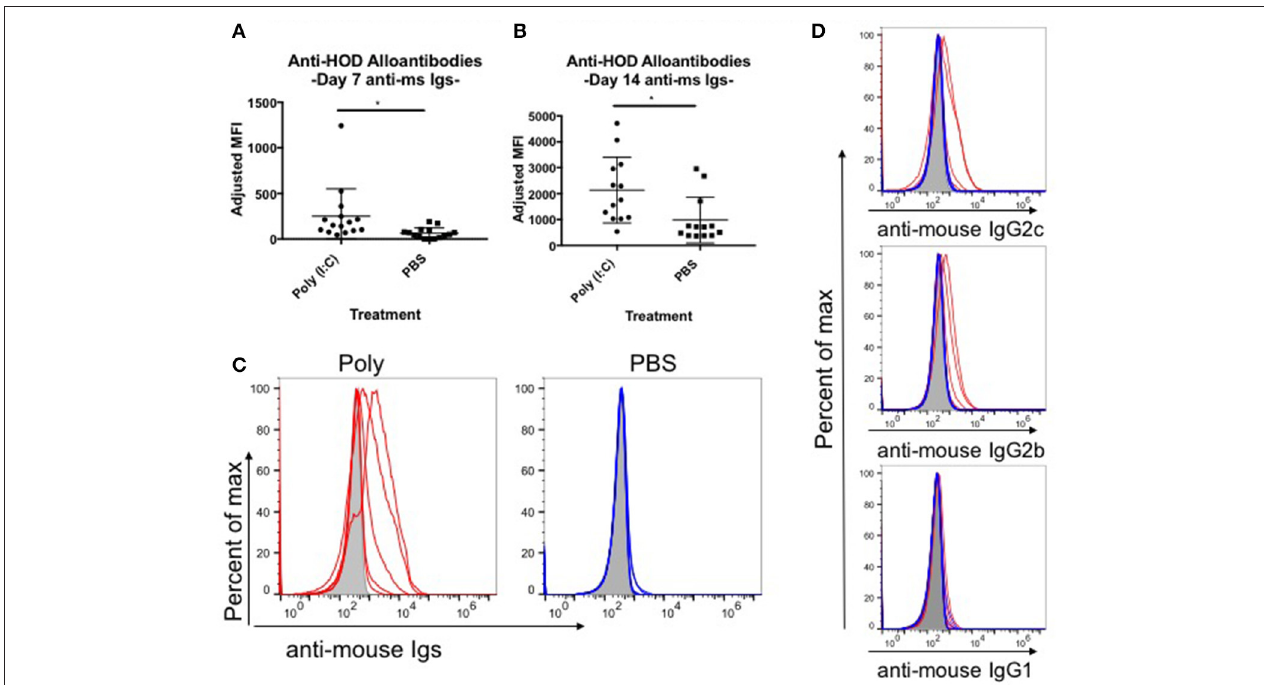
FIGURE 1 | Poly (I:C)-elicited inflammation enhances the magnitude and rate of alloimmunization to HOD RBCs. Recipient B6 mice were treated i.p. with 200 ug of poly (I:C) or PBS control 2–4h prior to a transfusion of 100 uL packed leukoreduced HOD RBCs. Sera was collected and assessed for anti-HOD alloantibodies by flow crossmatch against HOD RBC targets. The adjusted mean fluorescence intensity (MFI) of anti-mouse Igs APC secondary staining reagent was determined for days (A) 7 and (B) 14 post RBC transfusion. (C) Reactivity of day 14 serum to HOD RBC targets from individual mice in each group is shown by flow crossmatch against HOD RBC targets with total anti-mouse Igs and (D) subtype specific IgG secondary reagents. Naïve B6 sera incubated with HOD RBC targets is shown in shaded gray, poly (I:C) treated mice in red, and PBS treated animals in blue; each line represents an individual mouse. This experiment was repeated 3 times with 3–5 mice per group and all experiments are shown. Sera was used at 1:100 dilution. * p ≤ 0.05.